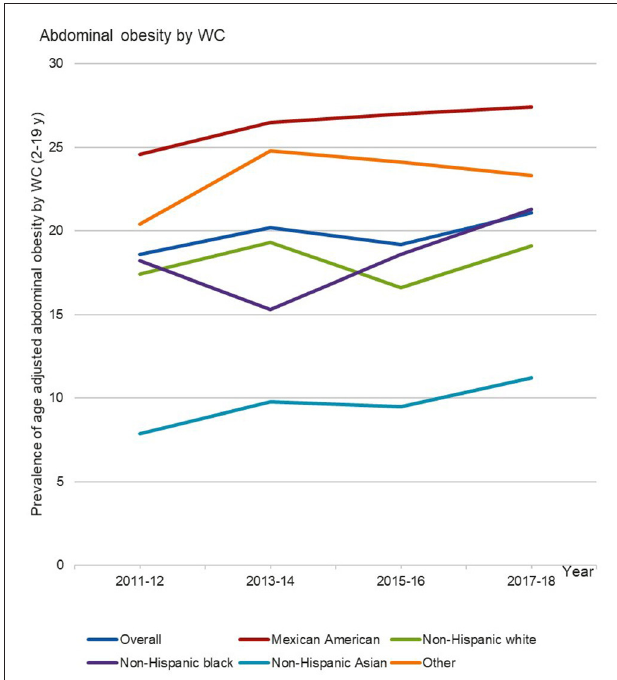
FIGURE 3 | Trends in age-adjusted prevalence of abdominal obesity by waist circumference among US children aged 2–19 y, NHANES 2011–2012 to